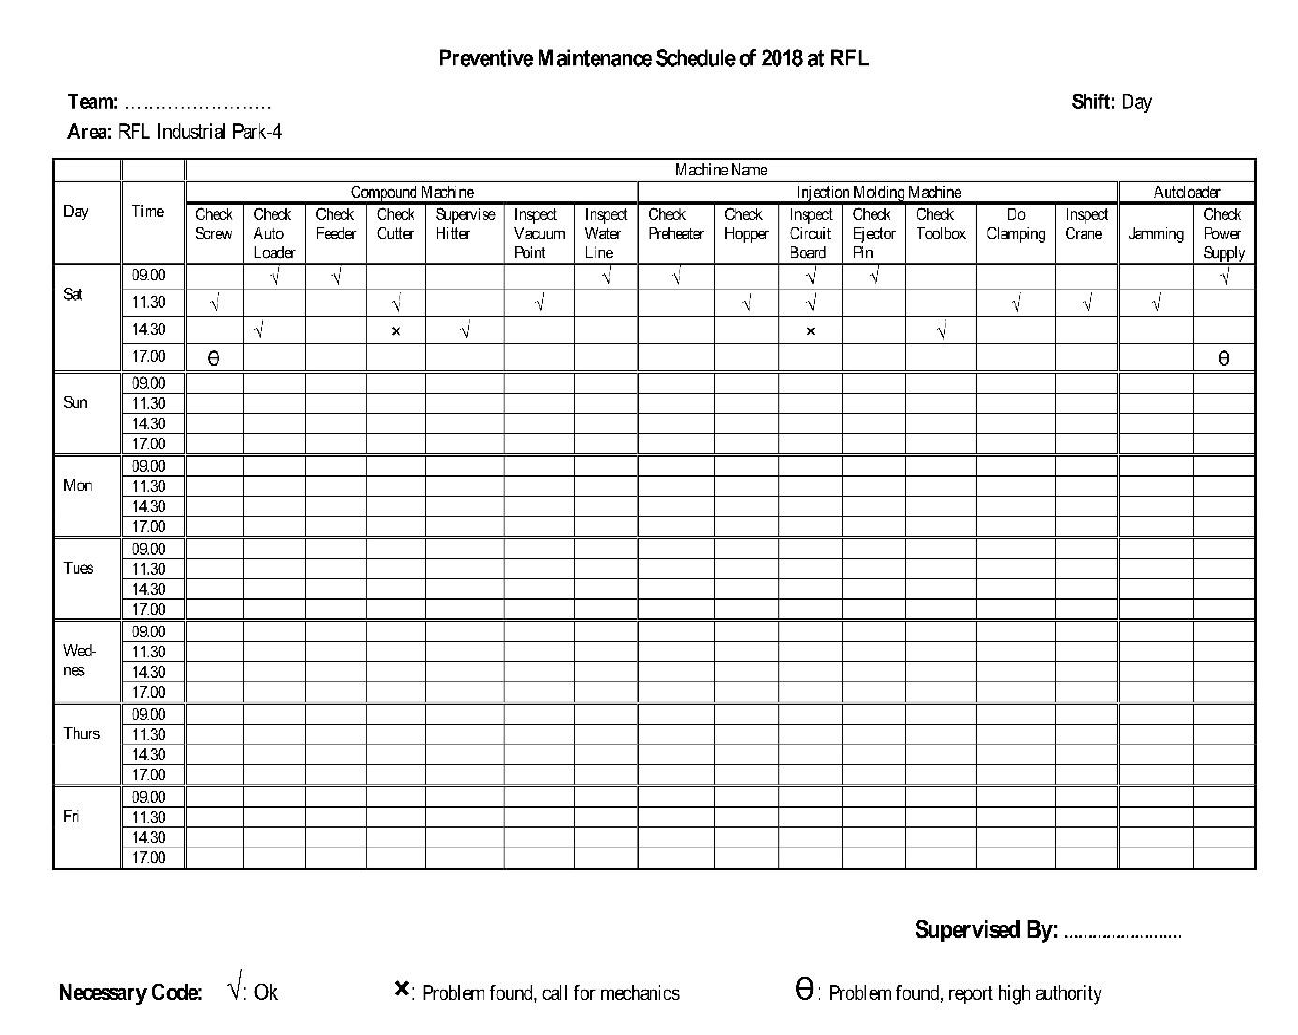
Figure 3. Preventive maintenanc e schedule